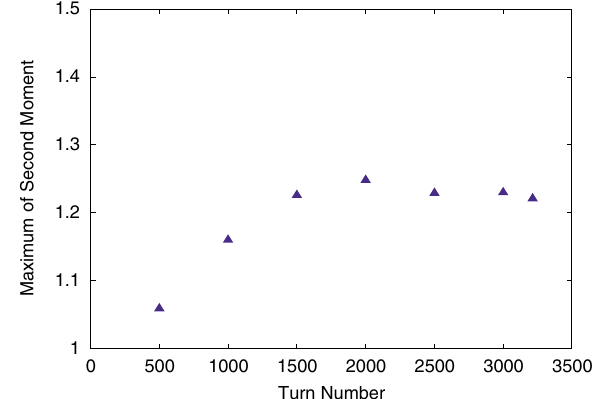
FIG. 9. (Color) PIC simulated maximum envelope oscillations p ) during accumulation of 4 : 37 (cid:2) 10 13 (cid:10) (normalized to (cid:1)(cid:1)(cid:1)(cid:1)(cid:1)(cid:1)(cid:1)(cid:1)(cid:1)(cid:1)(cid:1) (cid:8) y y protons in the PSR ring (colored